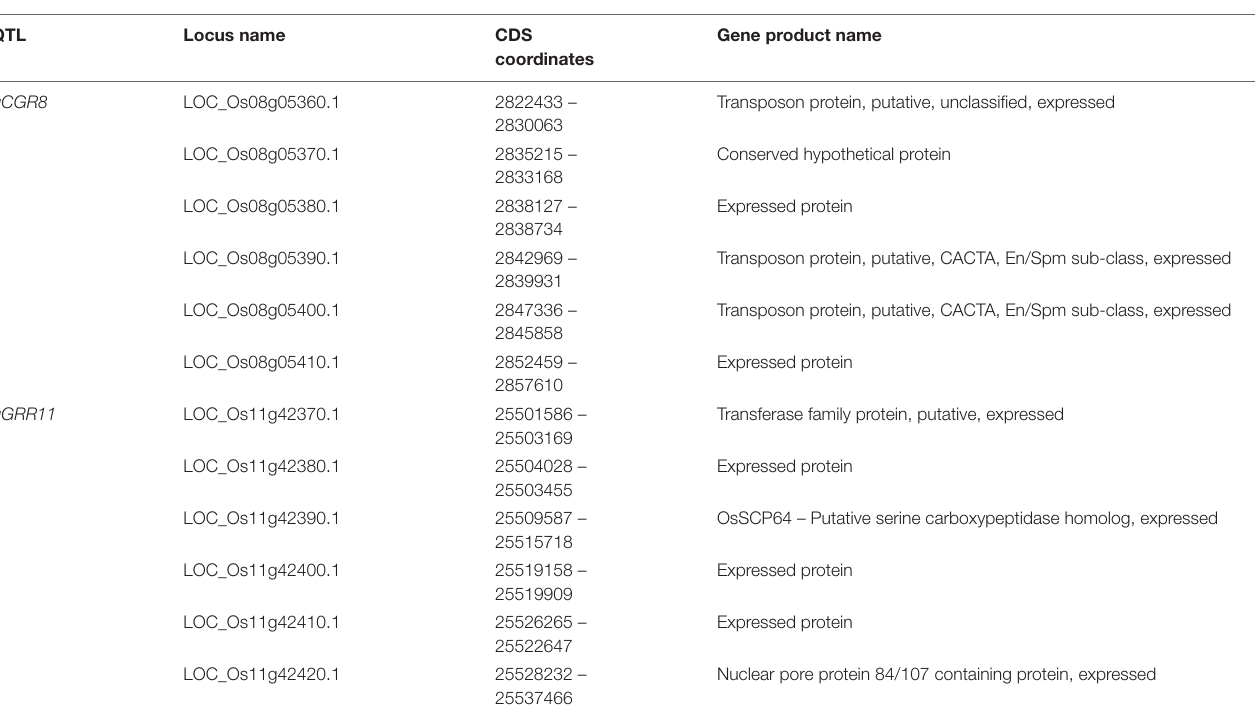
FIGURE 5 | The QTL position on the high density map of the BRIL population. TABLE 3 | The candidate genes for QTL qCGR8 and